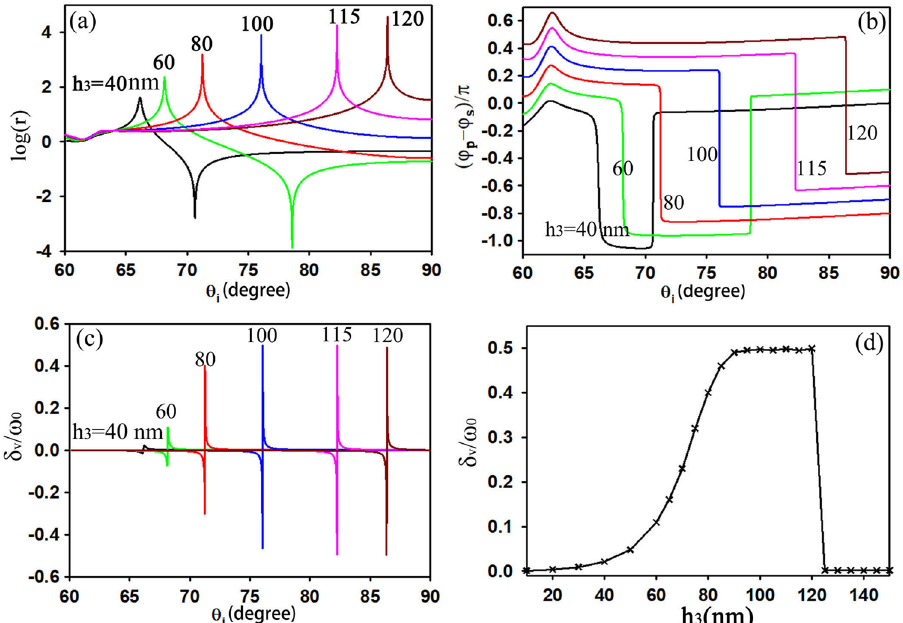
Figure 7. Log(r) (a) , phase difference (b) , and transverse shifts (c) of V-polarized input as functions of incident angle for different thicknesses of the BN. (d) The maximum transverse shift varying with the thickness of